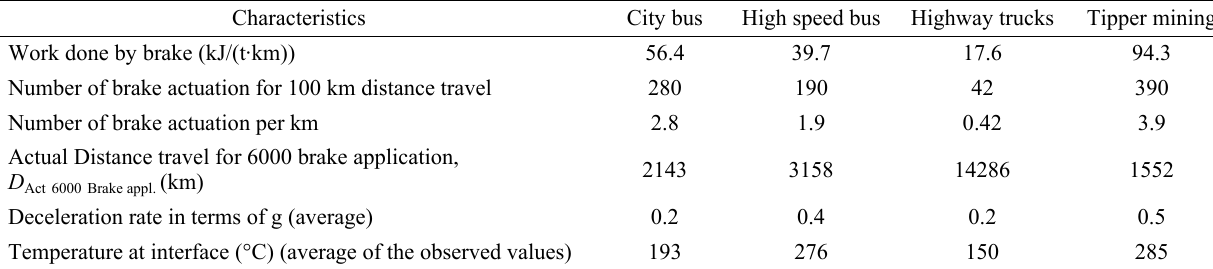
Table 2 Observations during the field